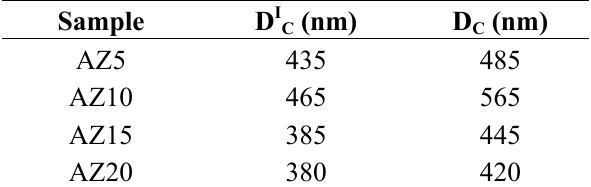
) and upper ( D ) critical sizes of zirconia for the AZ C C